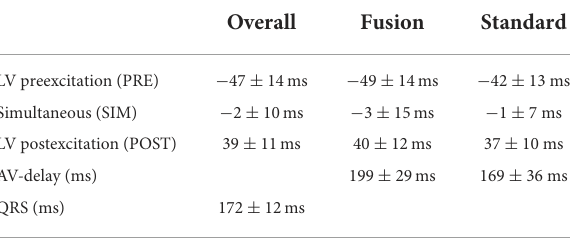
TABLE 2 Pacing intervals used for left ventricular pre-/postexcitation and mode of pacing (FUSION/STANDARD).